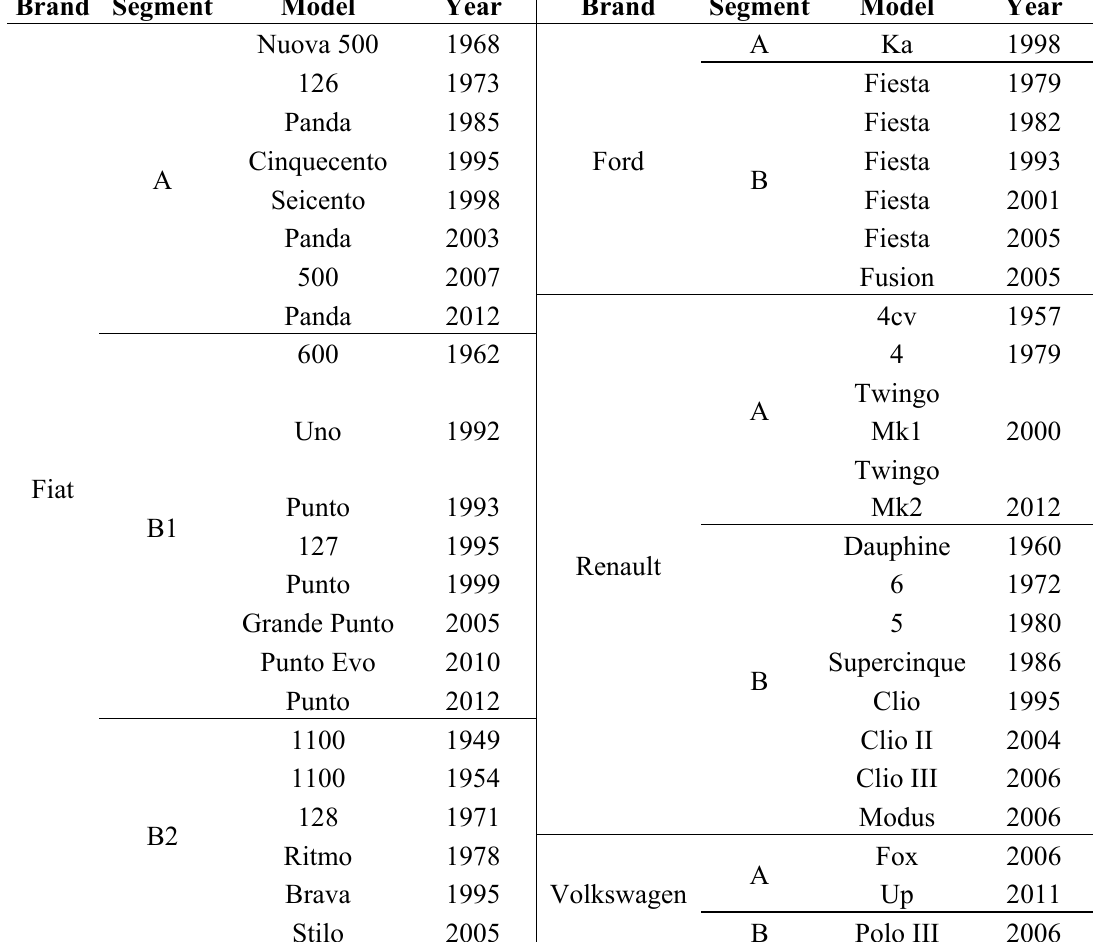
Table 1. Brands, segments, models, and years of cars considered in the morphometric